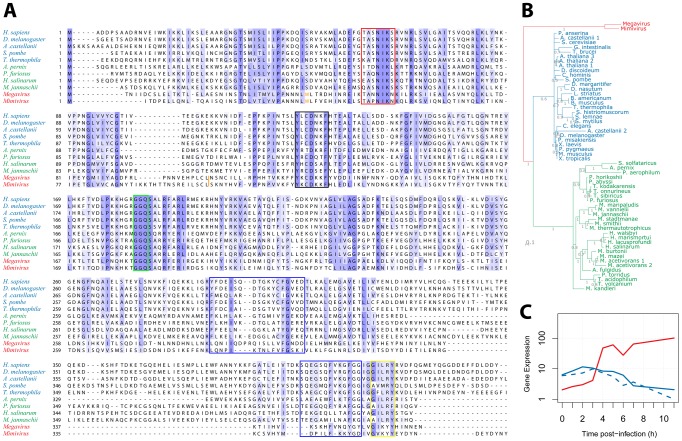
Multiple alignment of Mimivirus R726 and Megavirus mg280.A) Multiple alignment of Mimivirus R726 and Megavirus mg280 protein sequences (in red), as well as representative sequences from eukaryotic eRF1 (in blue) and archaeal aRF1 proteins (in green). Functionally important regions are boxed (see main text for a detailed description). The orange tryptophan is at the readthrough stop in Mimivirus and Megavirus sequences (see main text). The orange bar depicts the position of the Mimivirus and Megavirus frameshift stops. B) Phylogeny of Mimivirus, Megavirus, eukaryotic and archaeal class-I RFs using a Bayesian analysis of 58 sequences of 750 amino acid positions (321 ungapped) under the CAT60 mixture model (see materials and methods for details). The colors are the ones used in A. Branch support shown represents posterior probabilities and bar represents 0.1 substitutions per site. C) Gene expression profile (using RNA-seq data from [3]) of Mimivirus R726 gene is shown in red, the solid blue line shows the A. castellanii eRF1 expression and the dashed blue line shows the A. castellanii paralog expression.